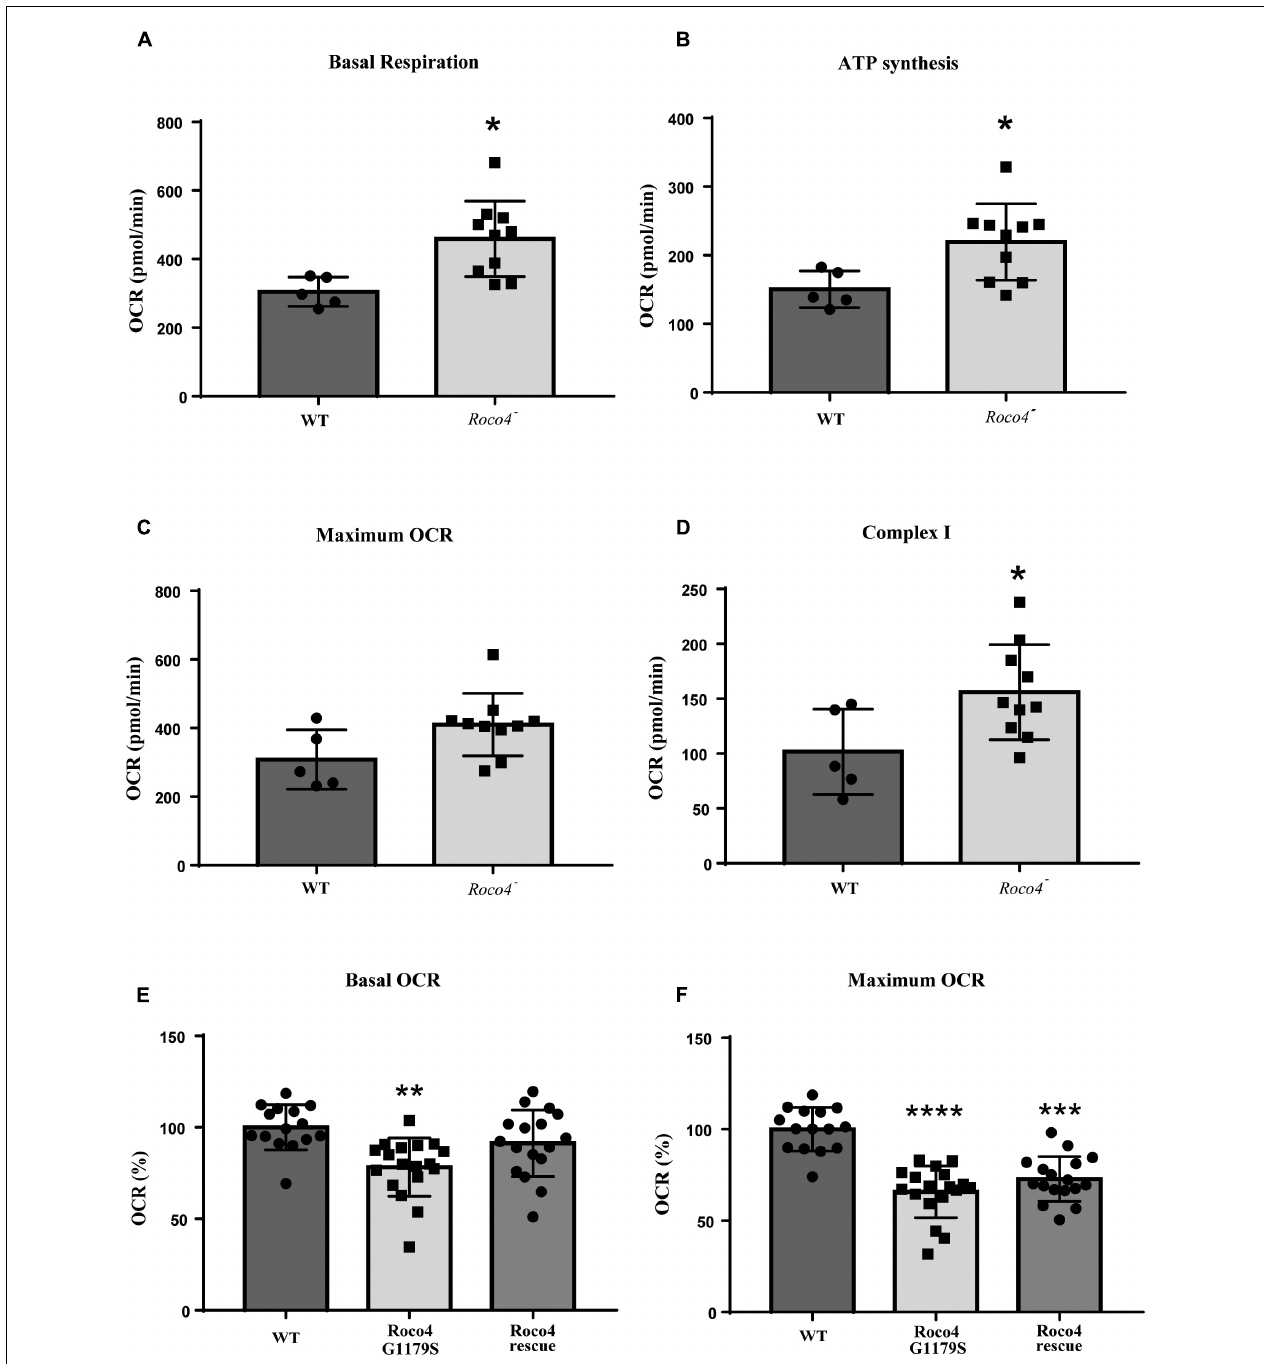
FIGURE 3 | Mitochondrial respirometry measurement in D. discoideum cells. The roco4- strain has enhanced mitochondrial respiratory activity while the Roco4 G1179S shows decreased mitochondrial respiration compared to the WT strain. Oxygen Consumption Rate (OCR) measurements were obtained over time (min) using an extracellular flux analyzer (Seahorse Bioscience). The mitochondrial stress test was used to obtain bioenergetic parameters. The figure shows the OCR values of the D. discoideum strains. (A–D) The roco4- strain has significantly elevated basal OCR, ATP synthesis rate and complex I activity compared to the WT. (C) The maximum OCR is slightly elevated though not significant. (E,F) Reduction in the basal and maximum OCR of the Roco4 G1179S strain relative to the WT while the Roco4 rescue cells show reduction only in the maximum OCR compared to the WT cells. All data are represented as mean ± SD. Statistical significance was assessed using unpaired t -test for the WT and the roco4- strains and one-way ANOVA with Tukey’s post-test or Kruskal–Wallis test for the WT, Roco4 G1179S and Roco4 rescue strains. P -values indicating statistically significant differences between the mean values compared to the WT control and are defined as follows: * p < 0.05, ** p < 0.01, *** p < 0.001, and **** p < 0.0001.